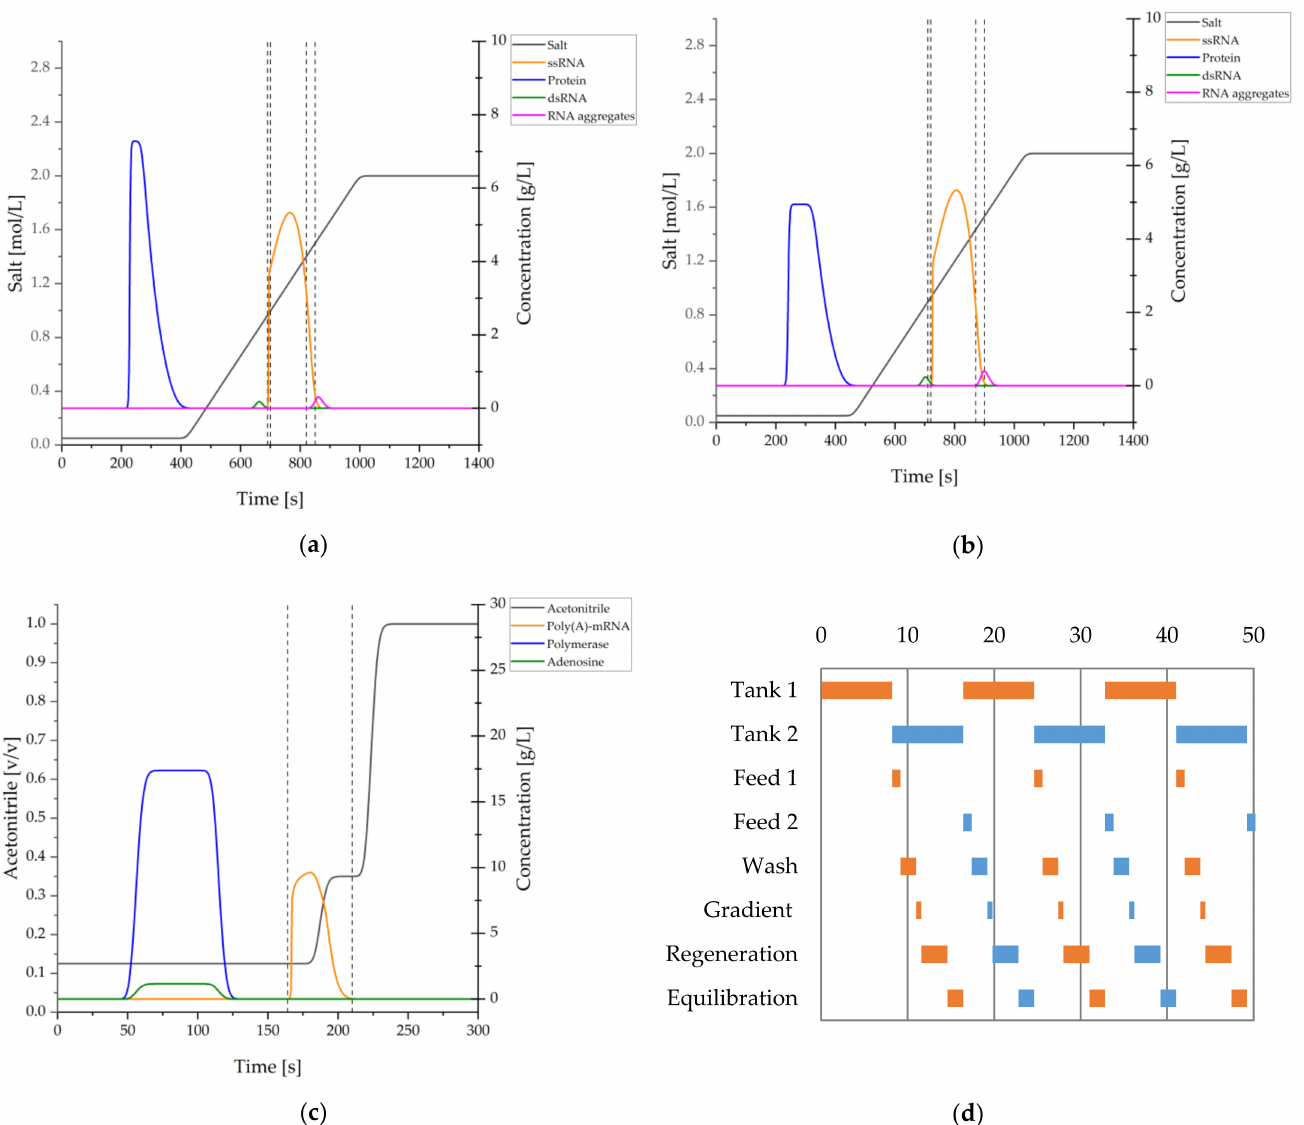
Figure 11. ( a ) Chromatogramm of the first cycle of bead-based MCSGP. ( b ) Chromatogramm of the fifth cycle of bead- based MCSGP. ( c ) Chromatogramm of the bead-based reversed-phase chromatography. ( d ) Scheduling of the two-column switching continuous process; numbers on the x -axis represent